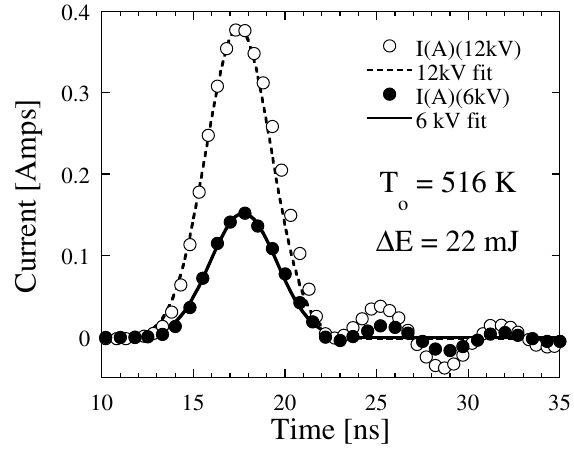
FIG. 3. Representative electron emission measurements for an incident laser striking a scandate dispenser cathode held at 516 K. Total time-integrated energy deposited is 22 mJ. The time scale of the Gaussian laser pulse is 2.7 ns. Anode potential was held at 12 kV (white dots) and 6 kV (black dots). The time scales of the Gaussian fits to the emission data are 2.52 and 2.57 ns,